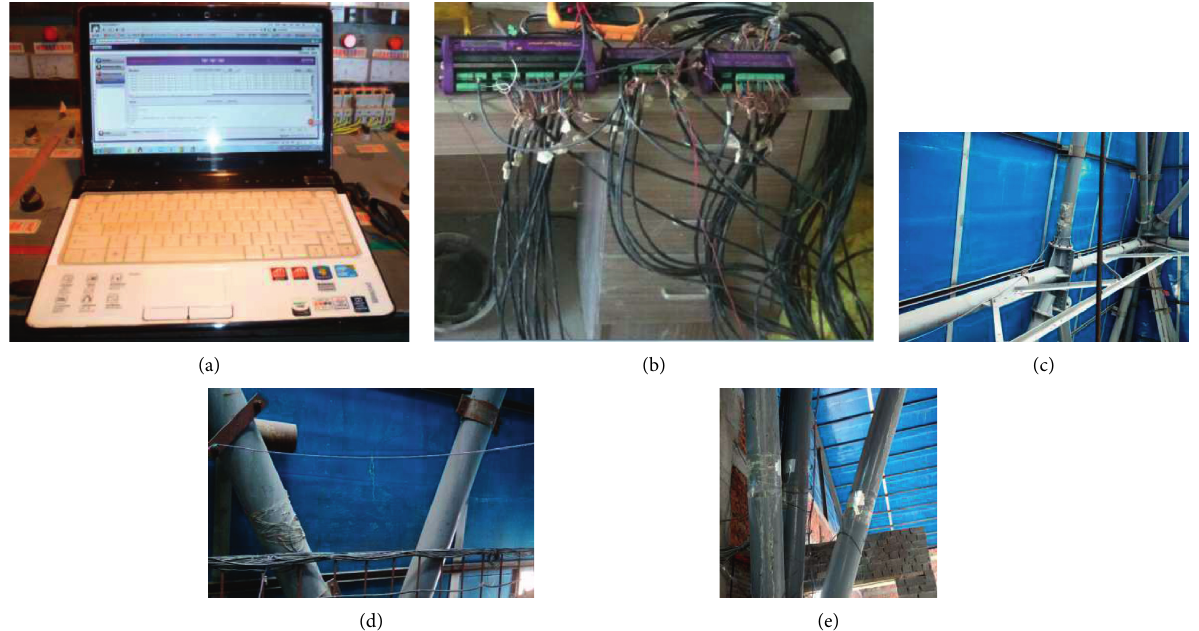
Figure 11: Field data acquisition. (a) Data acquisition equipment. (b) Datataker data acquisition. (c) Site map of upper measuring points. (d) Site map of middle measuring points. (e) Site map of lower measuring